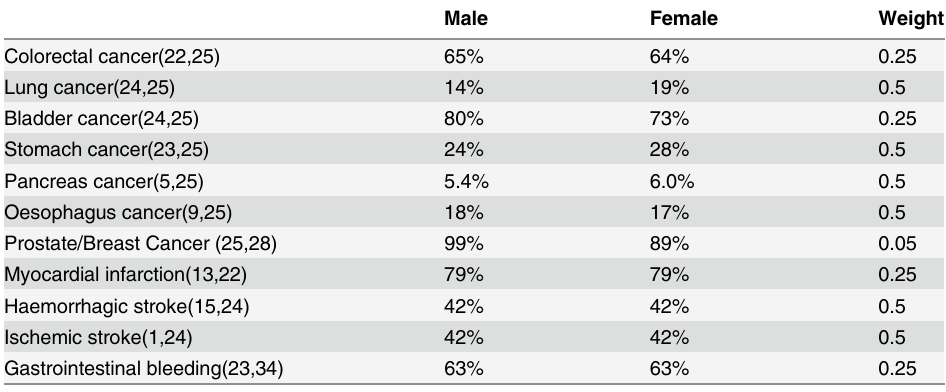
Table 2. Weights used in the first sensitivity analysis, based on 5-year survival.